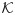
Internal Vs. external complexity in artificial systems over time.A comparison of computational complexity (# of transistors in the CPU) relative to a measure of mechanical complexity (K) on robotic platforms over time. Platform names are omitted for clarity; see S1 Appendix for full list. The unit of measure on both axes is bits; square plot axes highlight imbalance between internal and external states (although note that the axes use different ranges).